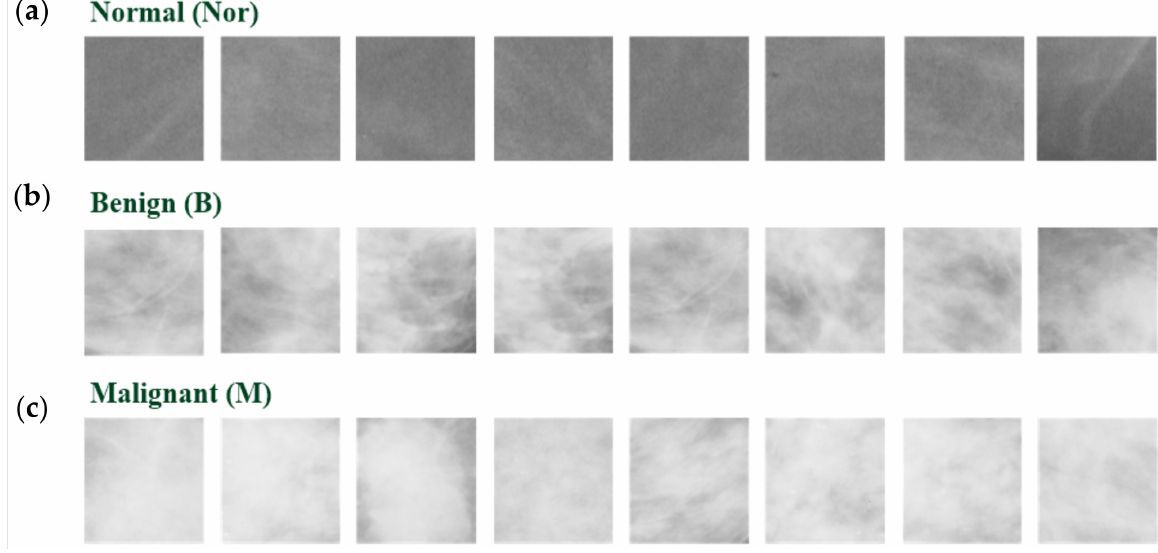
Figure 1. Templates of feature patterns are extracted from suspicious mammographic images with a specific bounding box. ( a ) Template patterns for normal, ( b ) template patterns for benign (B), and ( c ) template patterns for malignant